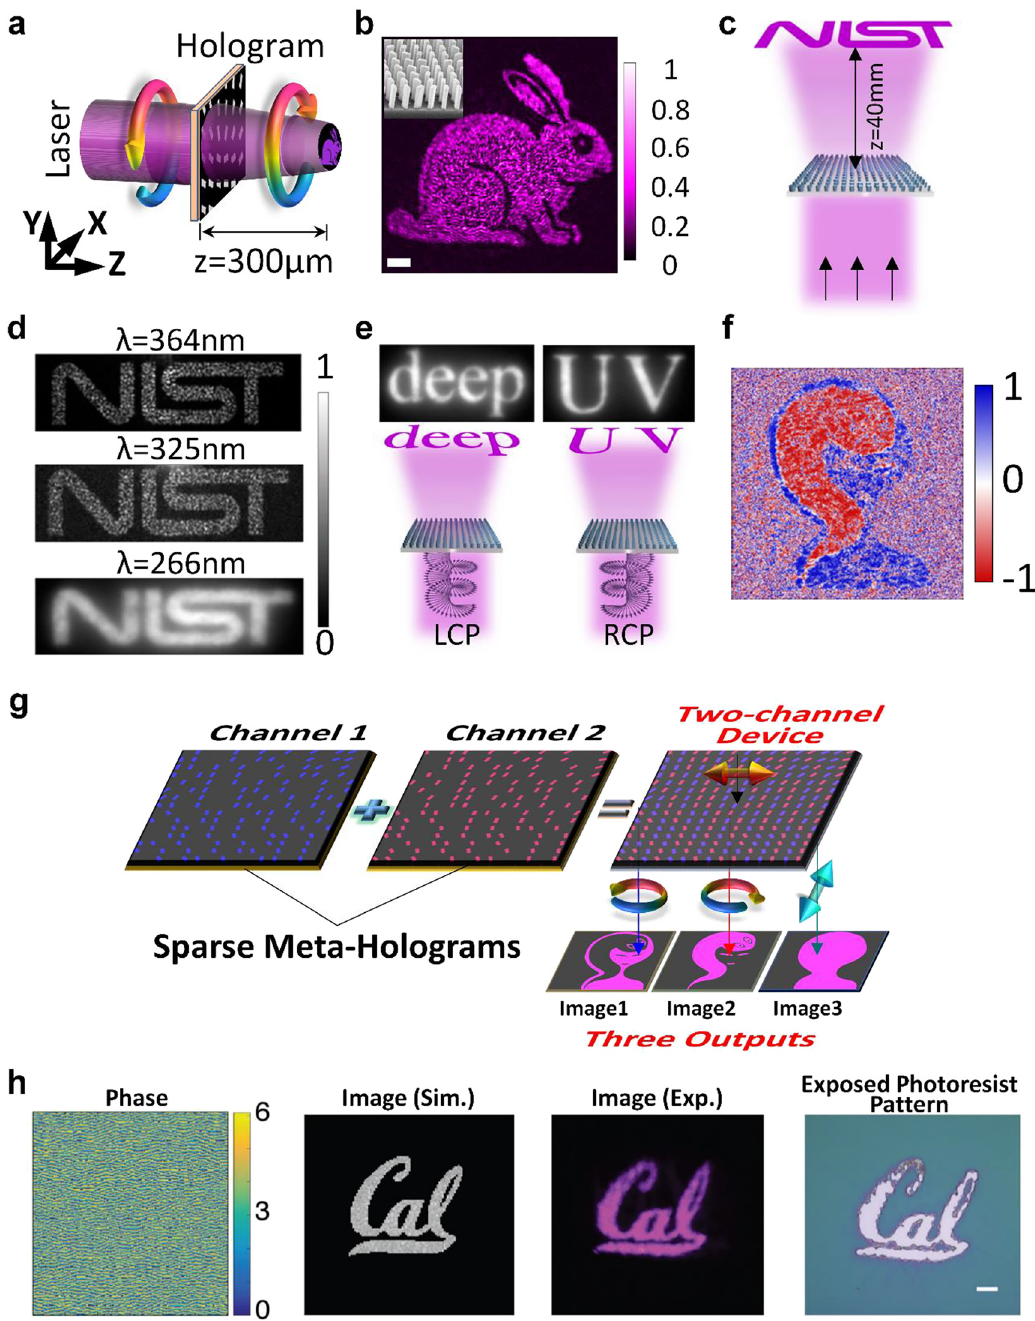
Figure10: (aandb)Sketch(a)fortheUVmetasurfacehologramandtheexperimentalholographicimage(b)byusingtheNb 2 O 5 nanobricksat the operating wavelength of 355 nm. Huang et al. [109]. © 2019, WILEY ‐ VCH Verlag GmbH & Co. KGaA, Weinheim. (c and d) Sketch (c) for the HfO 2 -based metahologram operating at the broadband wavelengths and their measured images (d). (e) Spin-multiplexed metahologram that reconstructs two spin-dependent images at the wavelength of 266 nm. Zhang et al. [106]. Author copyright. (f) Spin-multiplexed UV meta- surfaces encoding two sparse holograms that are used to create the complementary images of “ girl ” and “ snake ” . (g) Experimental holo- graphic image by labeling the polarization information where the blue color denotes the spin-up photons and the red for spin-down photons. Huangetal.[109].©2019,WILEY ‐ VCHVerlagGmbH&Co.KGaA,Weinheim.(h)Si-basedUVmetahologramforlithography.Thephasepro fi leof the hologramis shownat the left panel. The simulated,experimental, and exposedimagesare provided at the right panel byaddressingtheir names. Deng et al. [107]. © 2018 WILEY ‐ VCH Verlag GmbH & Co. KGaA,